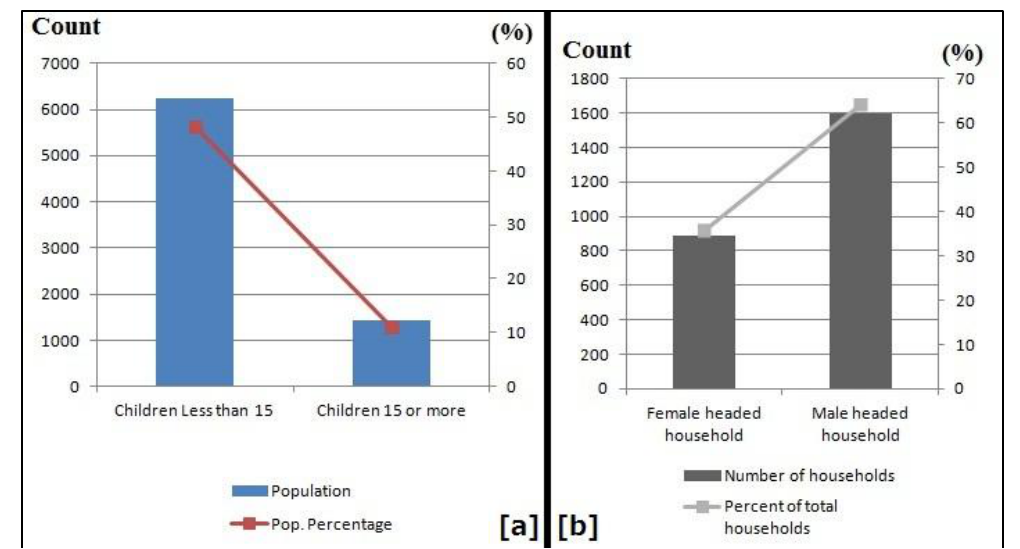
Figure 4. Population structure for Malingunde